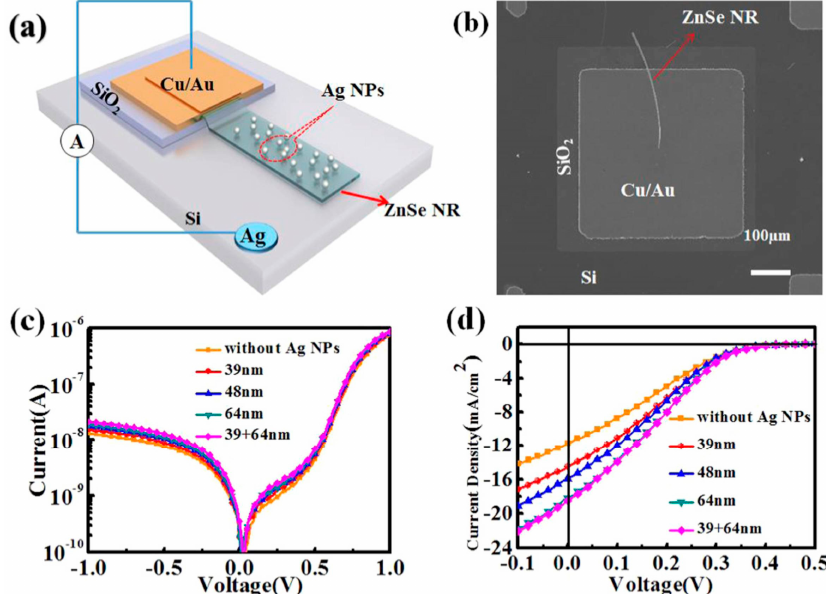
Figure 11. ( a ) Schematic illustration of ZnSe nanoribbon/Si heterojunction. ( b ) The top view SEM image of a single nanoribbon device. ( c ) Dark I-V characteristics of devices in the semi-logarithmic scale. ( d ) The J-V curves of devices embellished with different diameters of Ag nanoparticles measured under AM 1.5 G illumination at 100 mW cm − 2 . Reproduced with permission from [45], Copyright 2016, IOP Publishing Ltd.